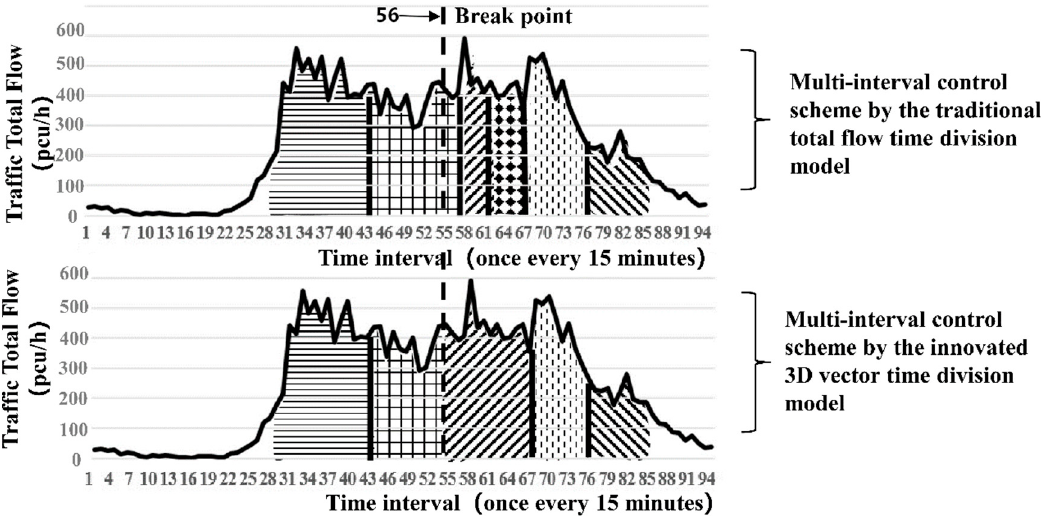
Figure 11. Scheme comparison diagram of the innovated time period division with the traditional total flow division (multi-peak-type representative: No. 61 intersection at Jiefang North Road and Renmin West Road). Table 4. Adaptability analysis table of the four types of intersections by the innovated time period division.